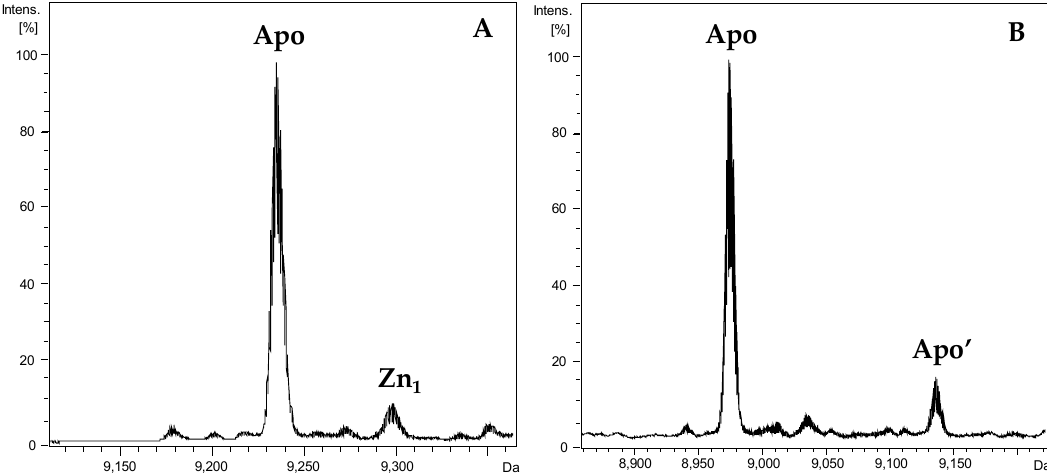
Figure 2. Deconvoluted ESI-MS spectra recorded at acidic conditions (pH 2.4) of ( A ) apo-PbrMT1 and ( B ) apo-PbrMT2 from